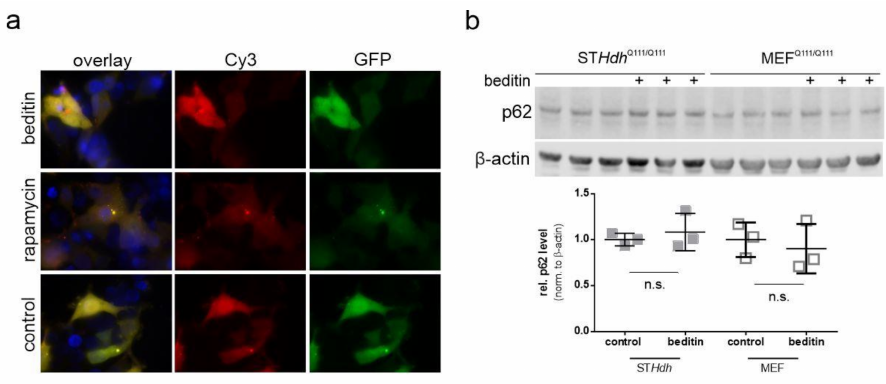
Figure A2. Beditin induces autophagy independent of mTOR. ( a ) Representative images of LC3B– mCherry–EGFP overexpression in HEK293T cells treated with beditin, rapamycin, or PBS (control). ( b ) Western blot and quantification of p62 levels after 24 h of beditin treatment in ST Hdh Q111/Q111 and MEF Q111/Q111